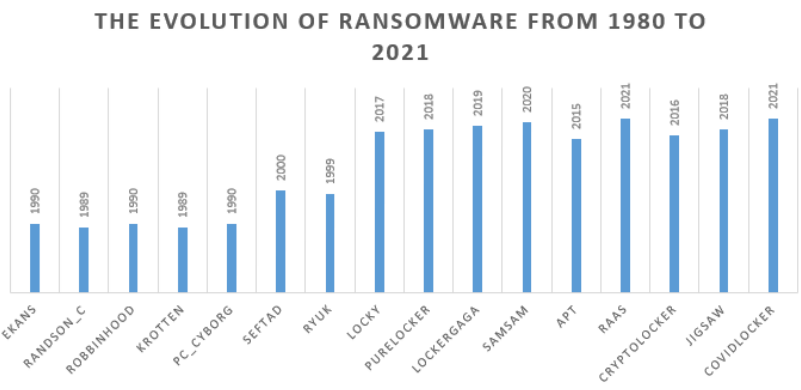
Figure 5. The year distribution of ransomware. RAAS stands for ransomware as a service.